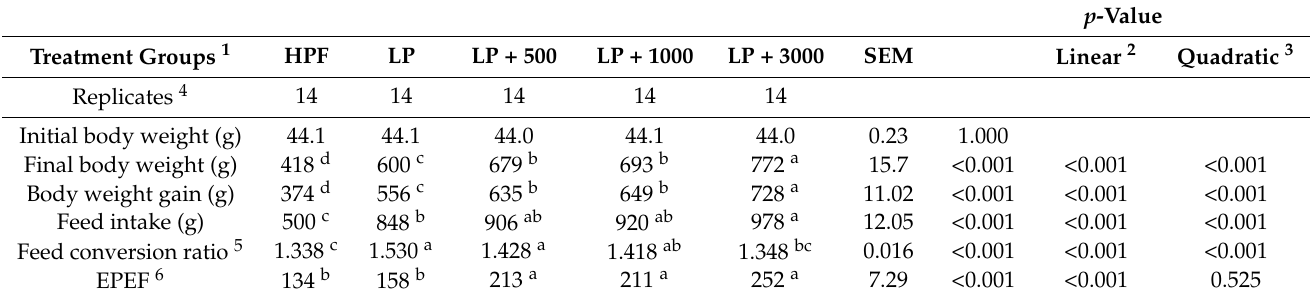
Table 2. Effect of different inclusion levels of phytase on growth performance of broiler chickens.